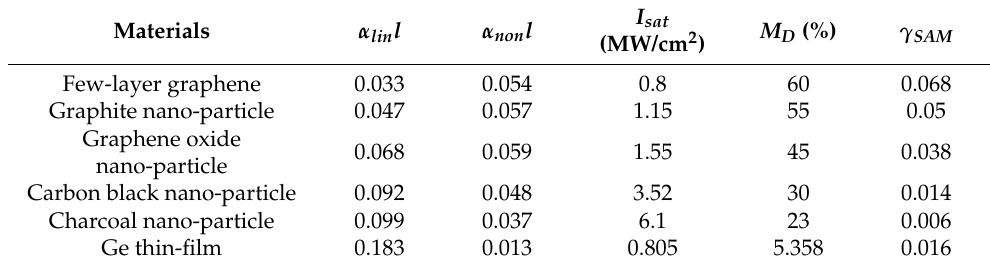
I sat M D (%) γ SAM (MW/cm 2 )